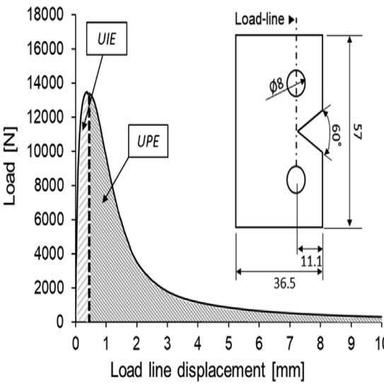
Load vs load-line displacement curve from Kahn-type tear tests and specimen geometry used for the tear tests.